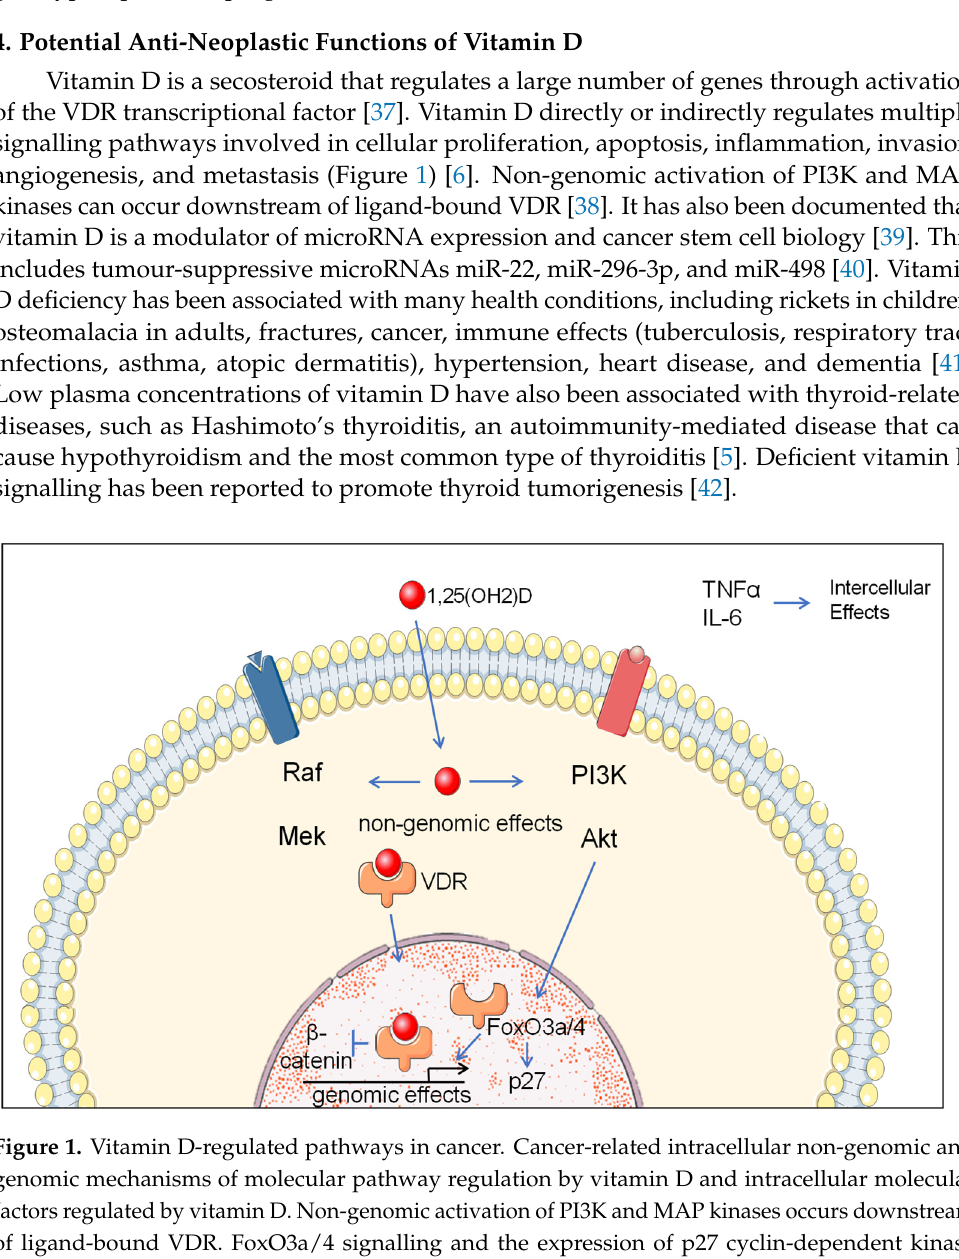
Table 1. Potential anti-tumorigenic mechanisms of vitamin D.